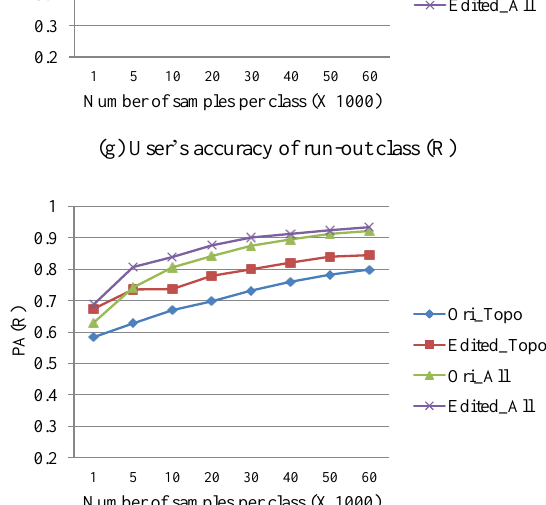
Figure 2. Evaluations of classification-based landslide susceptibility models considering different number of samples, using original (Ori) and edited (Edited) DEM as well as